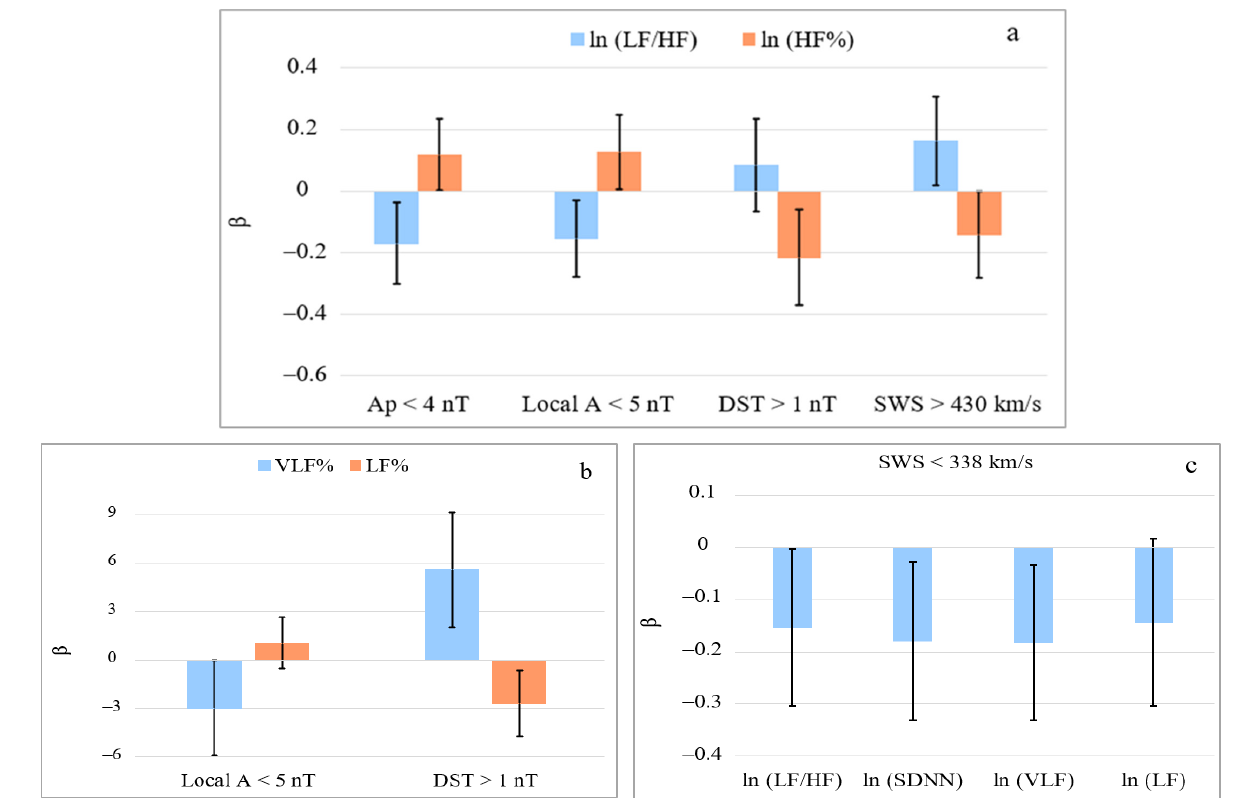
Figure 2. The effects of Ap, local A , and DST on the previous day ( a,b ), and SWS on the day of the ECG ( a,c ) quartiles on HRV variables ( β coefficients with 95% confidence interval adjusting for the linear trend and month).